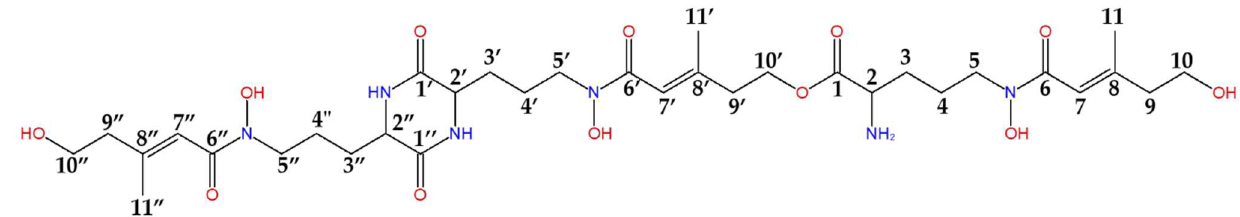
1 H-NMR and 13 C-NMR